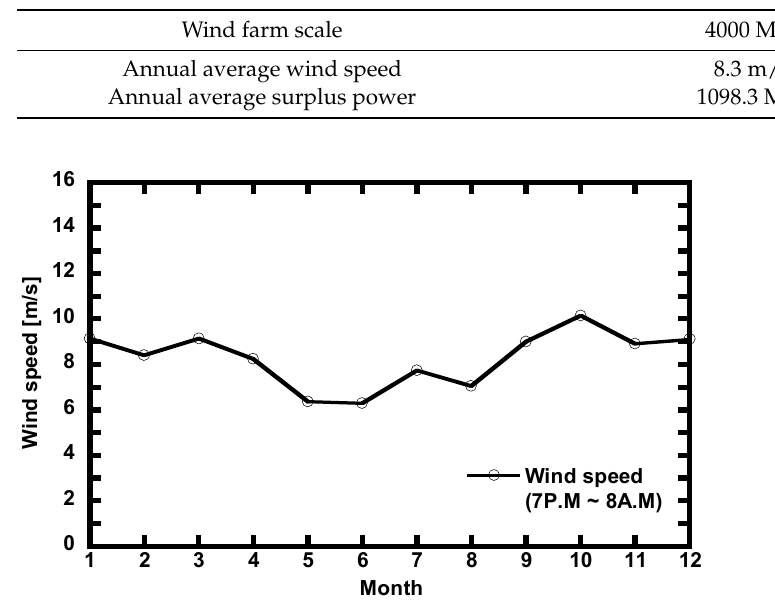
Table 5. Data for the offshore wind farm.